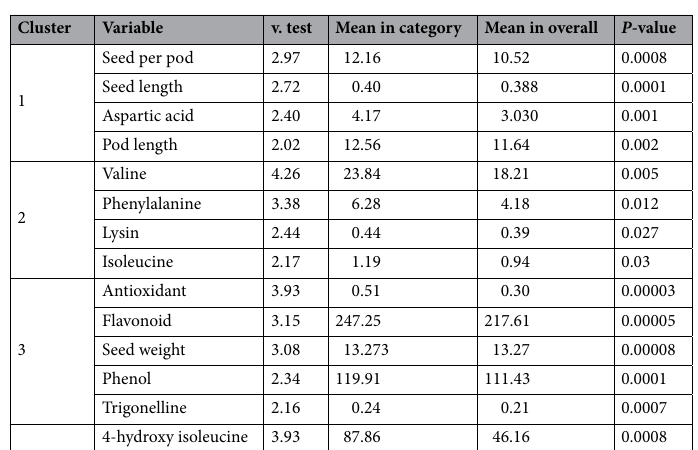
Table 3. Yield related traits and metabolic traits, v. test, and P -value, and the most contributed dimensions to clusters I, II and III after HCPC analysis.